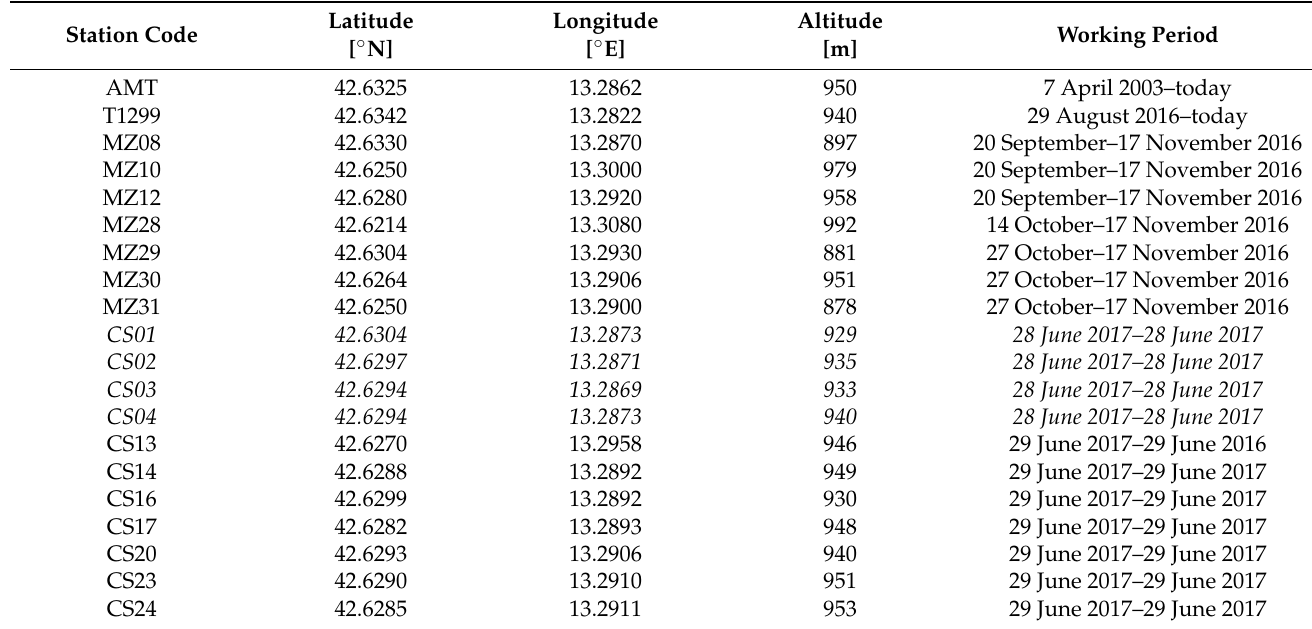
Table 2. List of the seismic stations installed in the Amatrice municipality (see [25,31]). For each station, the geographic coordinates and the working periods are reported. Stations CS01–04 (in italic) were not used for the 24 August 2016